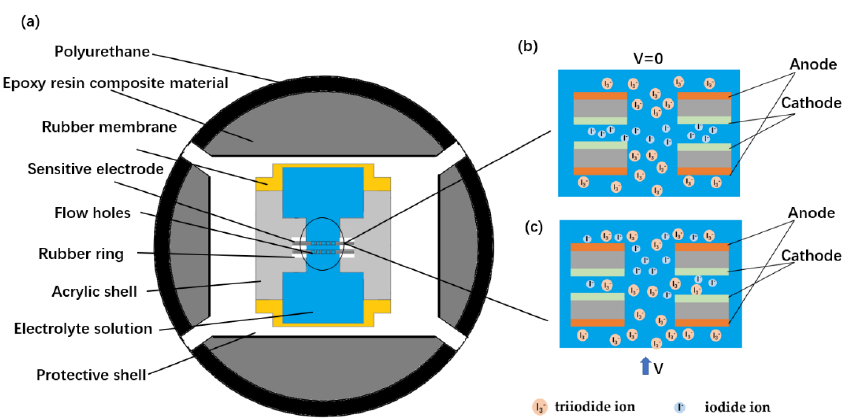
Figure 1. ( a ) Schematic diagram of the vector hydrophone based on the MEMS micro-electrochemical vibration sensor, consisting of: (1) an acrylic shell, (2) a pair of sensitive electrodes with many flow holes, (3) an electrolyte solution, (4) a rubber membrane, (5) a protective shell, (6) an epoxy resin composite material, and (7) polyurethane material. ( b ) Enlarged schematic diagram of the sensitive electrodes and the ion distribution in the absence of external vibration. ( c ) Enlarged schematic diagram of the sensitive electrodes and the ion distribution with an external vibration.